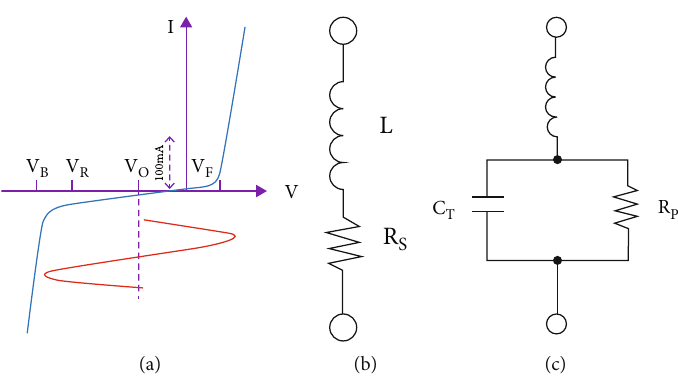
Figure 4: (a) V-I characteristic of PIN diode. (b, c) Equivalent model under forward and reverse